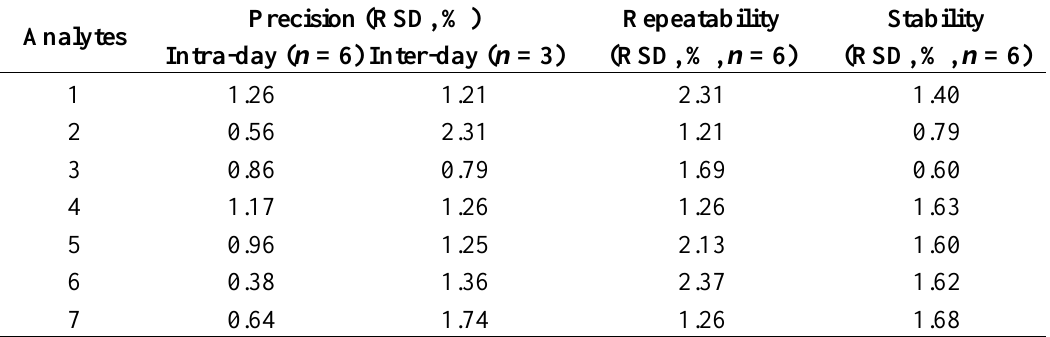
Table 2. Precision, repeatability and stability for the terpene lactones and flavonol aglycones in the G. biloba leaves.